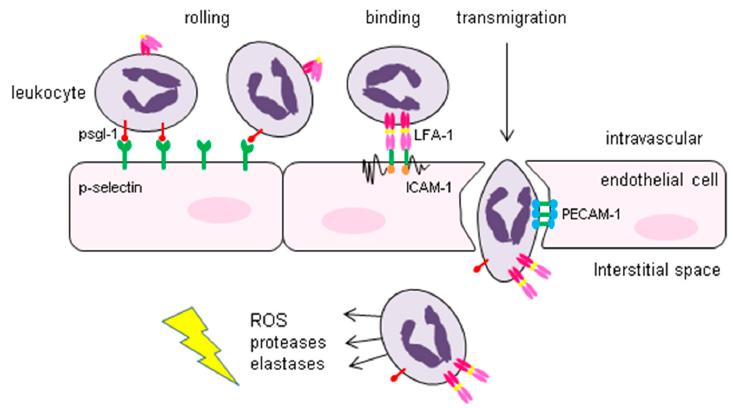
Figure 5. Interaction of leukocytes and endothelial cells in the process of transmigration of leukocytes. The increased expression of P-selectin on the endothelial cells upon I / R facilitates interaction with P-selectin glycoprotein 1 (PSGL-) expressed on the leukocytes. This results in rolling of the leukocytes on the endothelium. Subsequently, firm adherence of the leucocytes to the endothelium is achieved by interaction of lymphocyte function-associated antigen 1(LFA-1) and macrophage-1 antigen (MAC-1 or complement receptor 3, CR3) on the leukocyte and the intracellular adhesion molecule 1 (ICAM-1) on the endothelial cells. Finally, platelet endothelial cell adhesion molecule 1 (PECAM-1) facilitates transmigration of the leukocytes into the interstitial space. Once activated, these leukocytes will release several toxic substances like ROS, proteases, elastases and di ff erent cytokines in the interstitial compartment resulting in further injury like increased vascular permeability, oedema, thrombosis and parenchymal cell